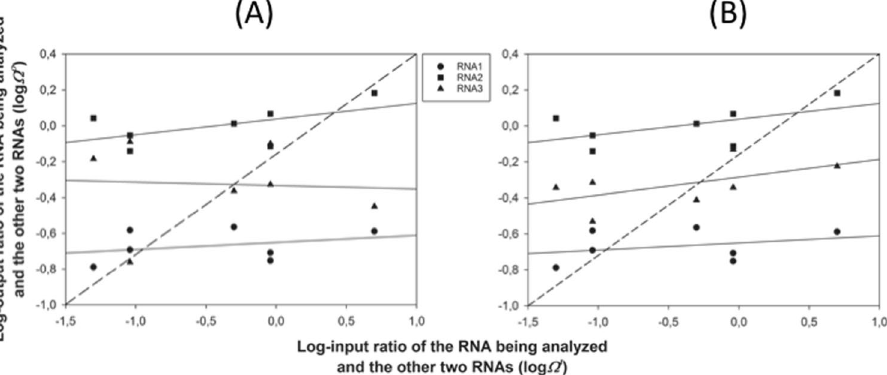
Figure 2. Graphical analysis of FDS as a mechanism to explain the relative abundance of the three RNA segments. ( A ) Abundances estimated from total RNA samples. ( B ) Abundances estimated from RNA extracted from viral particles. The dashed line corresponds to the null hypothesis of no-FDS. The continuous lines show the best fitting linear model to the relative abundances of each RNA.